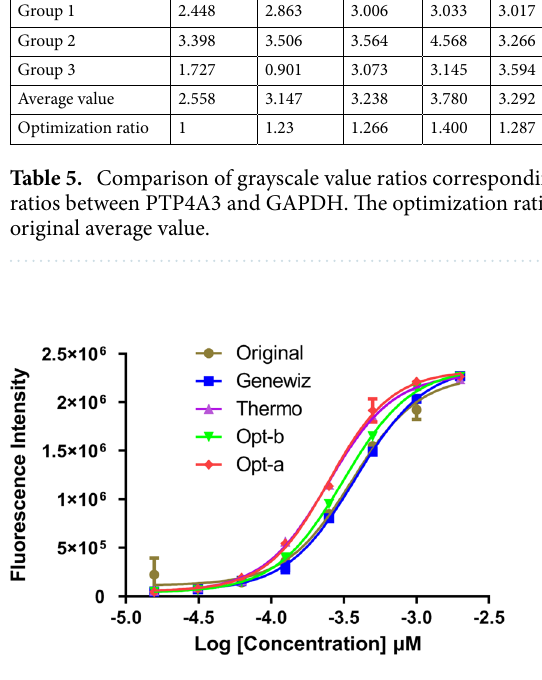
Figure 4. The assay of protein function for PTP4A3. In vitro phosphatase assays showed that the activities of proteins expressed by five sequences were almost equal (where p > 0.05). Different sequences are represented by different